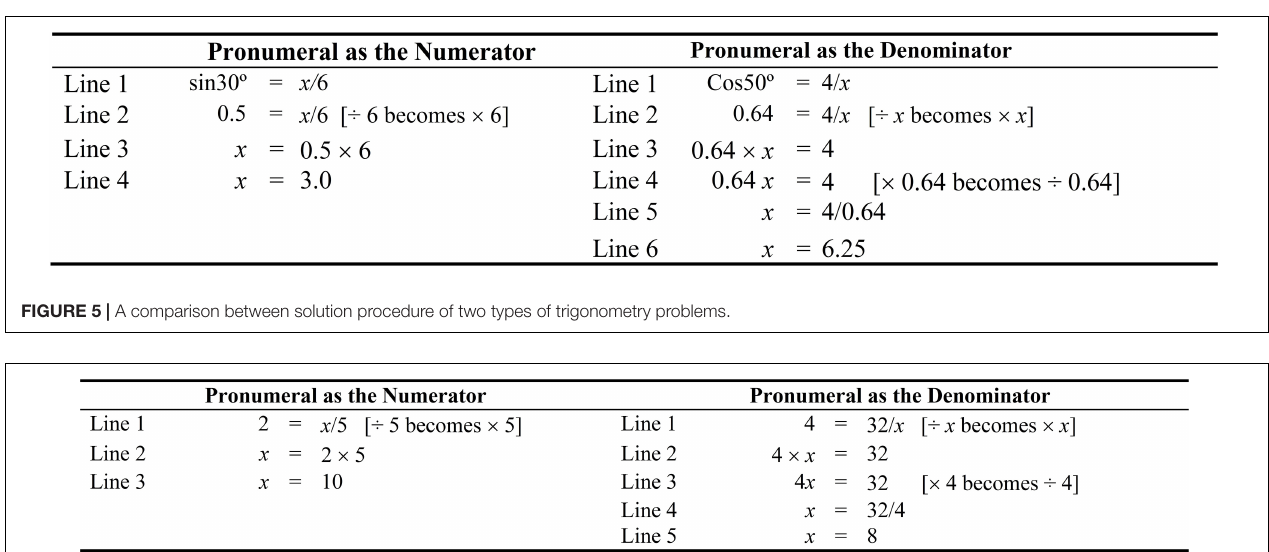
Frontiers in Psychology |